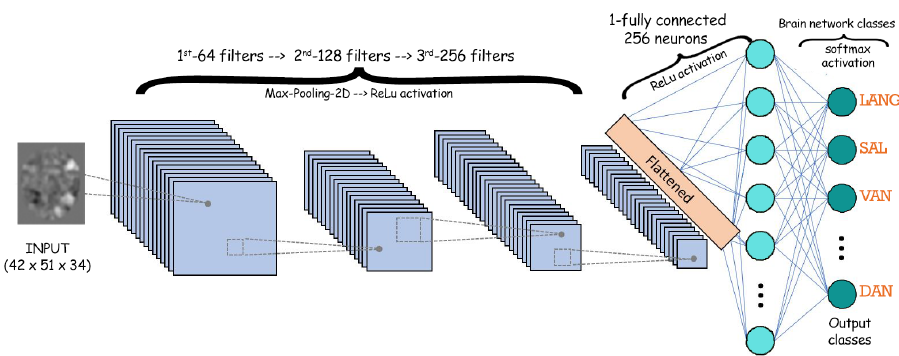
Figure 3. Three-layer convolutional neural network (CNN) model